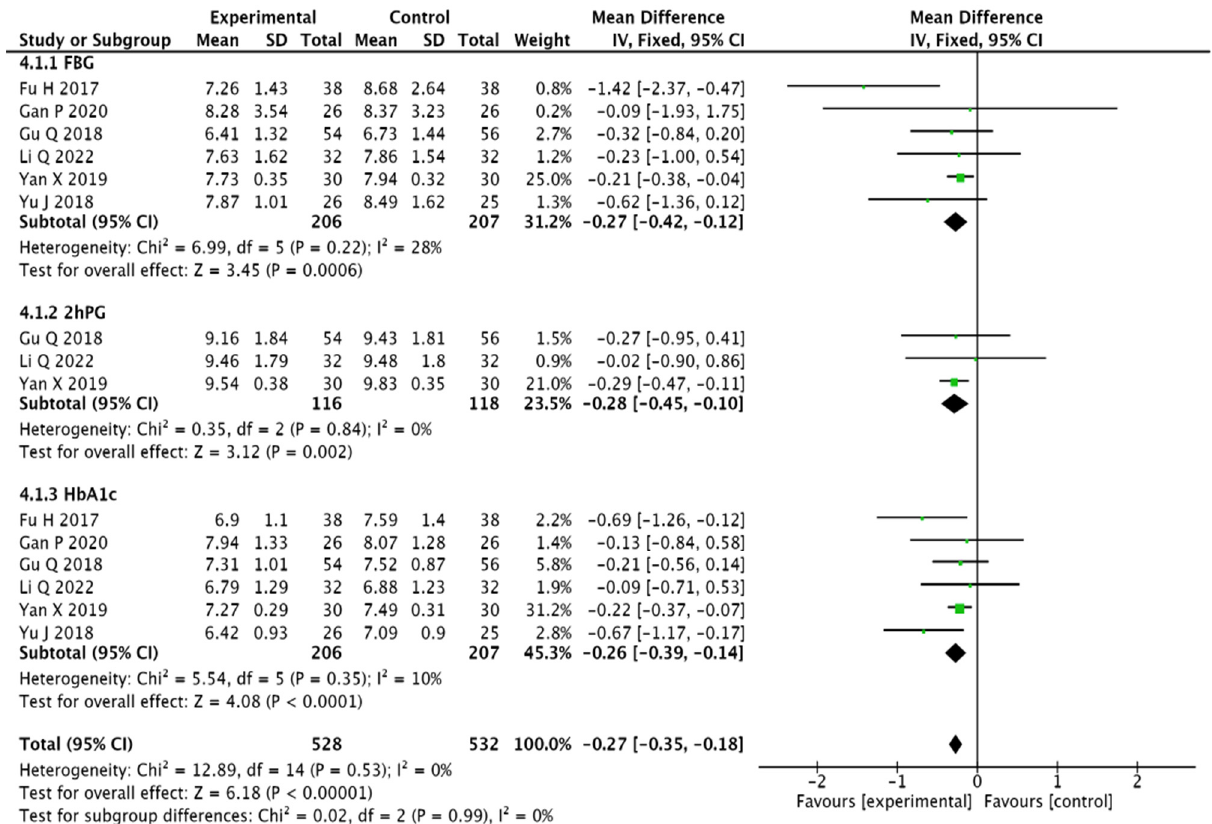
8 of 14 Figure 7. Forest plot of TCM symptom score. 3.3.5. Blood Glucose Indicators